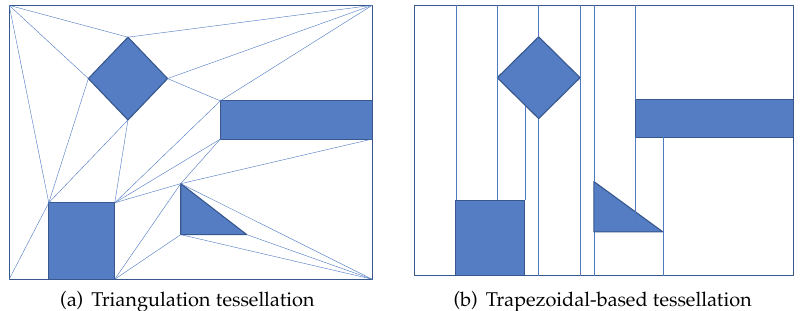
Figure 4: Examples of free-space tessellation